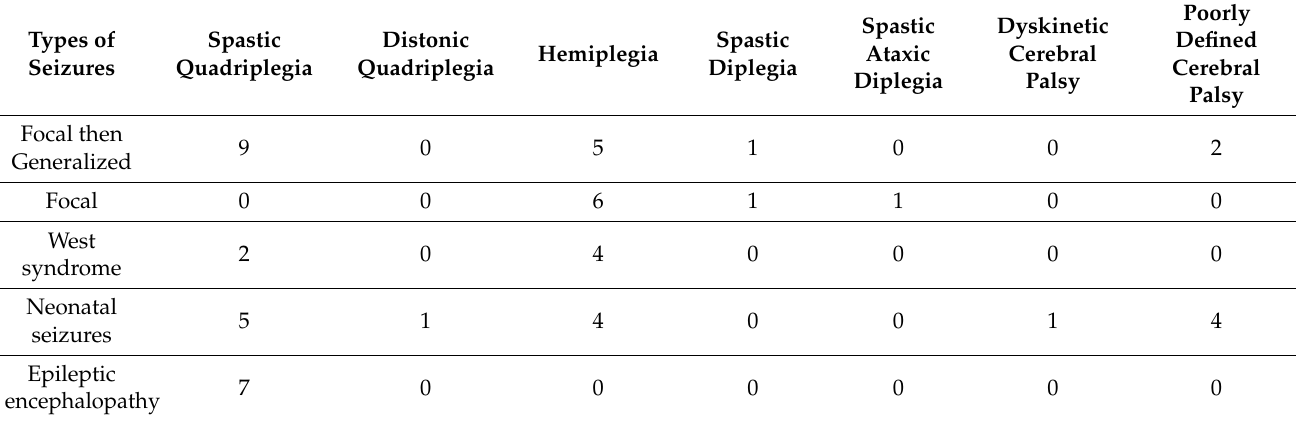
Table 4. Types of epileptic seizures selected according the type of